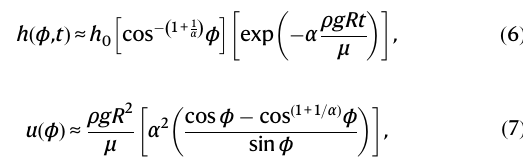
line)ortwono-slipinterfaces 17,18 (bluedottedline)leadtoafairlyuniformthickness. b Plottingthespatialvelocitypro fi le U ( ϕ )againstthepolarangle ϕ ,we fi ndthatthe incline plug fl ow model (dotted line) signi fi cantly overestimates the drainage speed. Inset: The numerical model of elongation fl ow captures the trend of the experimental data for drainage. Note that the marker symbol differentiates the tracer particles ( Δ — talcum powder; ∇ — glass microbubbles) and marker shading denotes the viscosity following the legend in Fig.